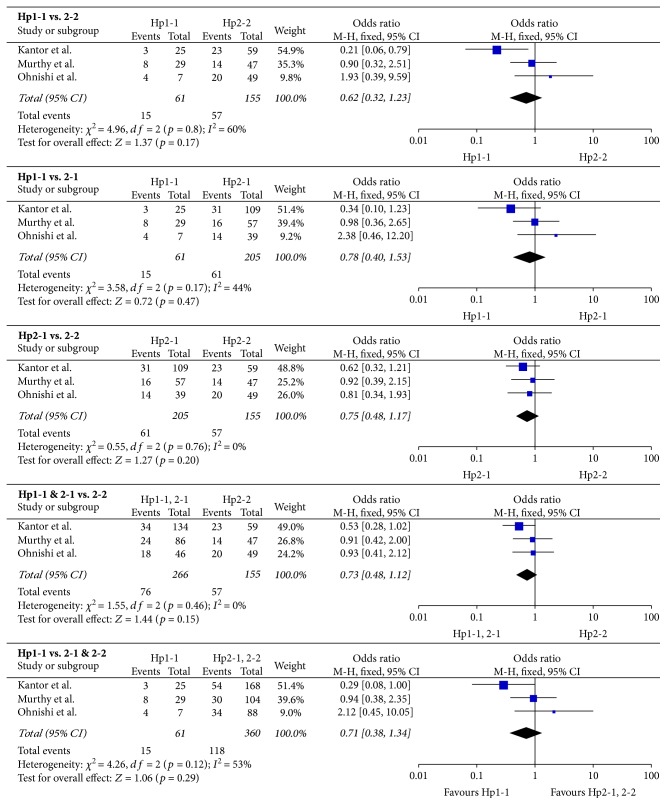
Forest plots for long-term outcome data. Long-term outcome was defined as dichotomized mRS or GOS, between one and three months after aSAH.